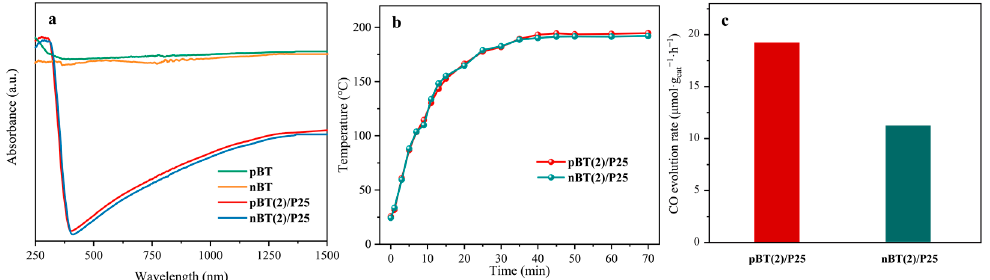
Figure 5. ( a ) UV-vis-IR spectra of pBT, nBT, pBT(2)/P25, and nBT(2)/P25; ( b ) In situ monitoring of the photothermal temperatures over pBT(2)/P25 and nBT(2)/P25; ( c ) CO evolution rates over pBT(2)/P25 and nBT(2)/P25 under a 300 W full-arc Xe lamp illumination.